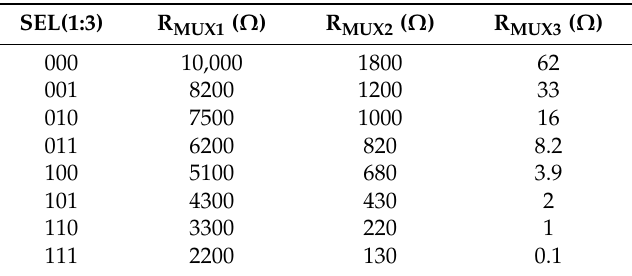
Table 1. Resistor values in the variable load